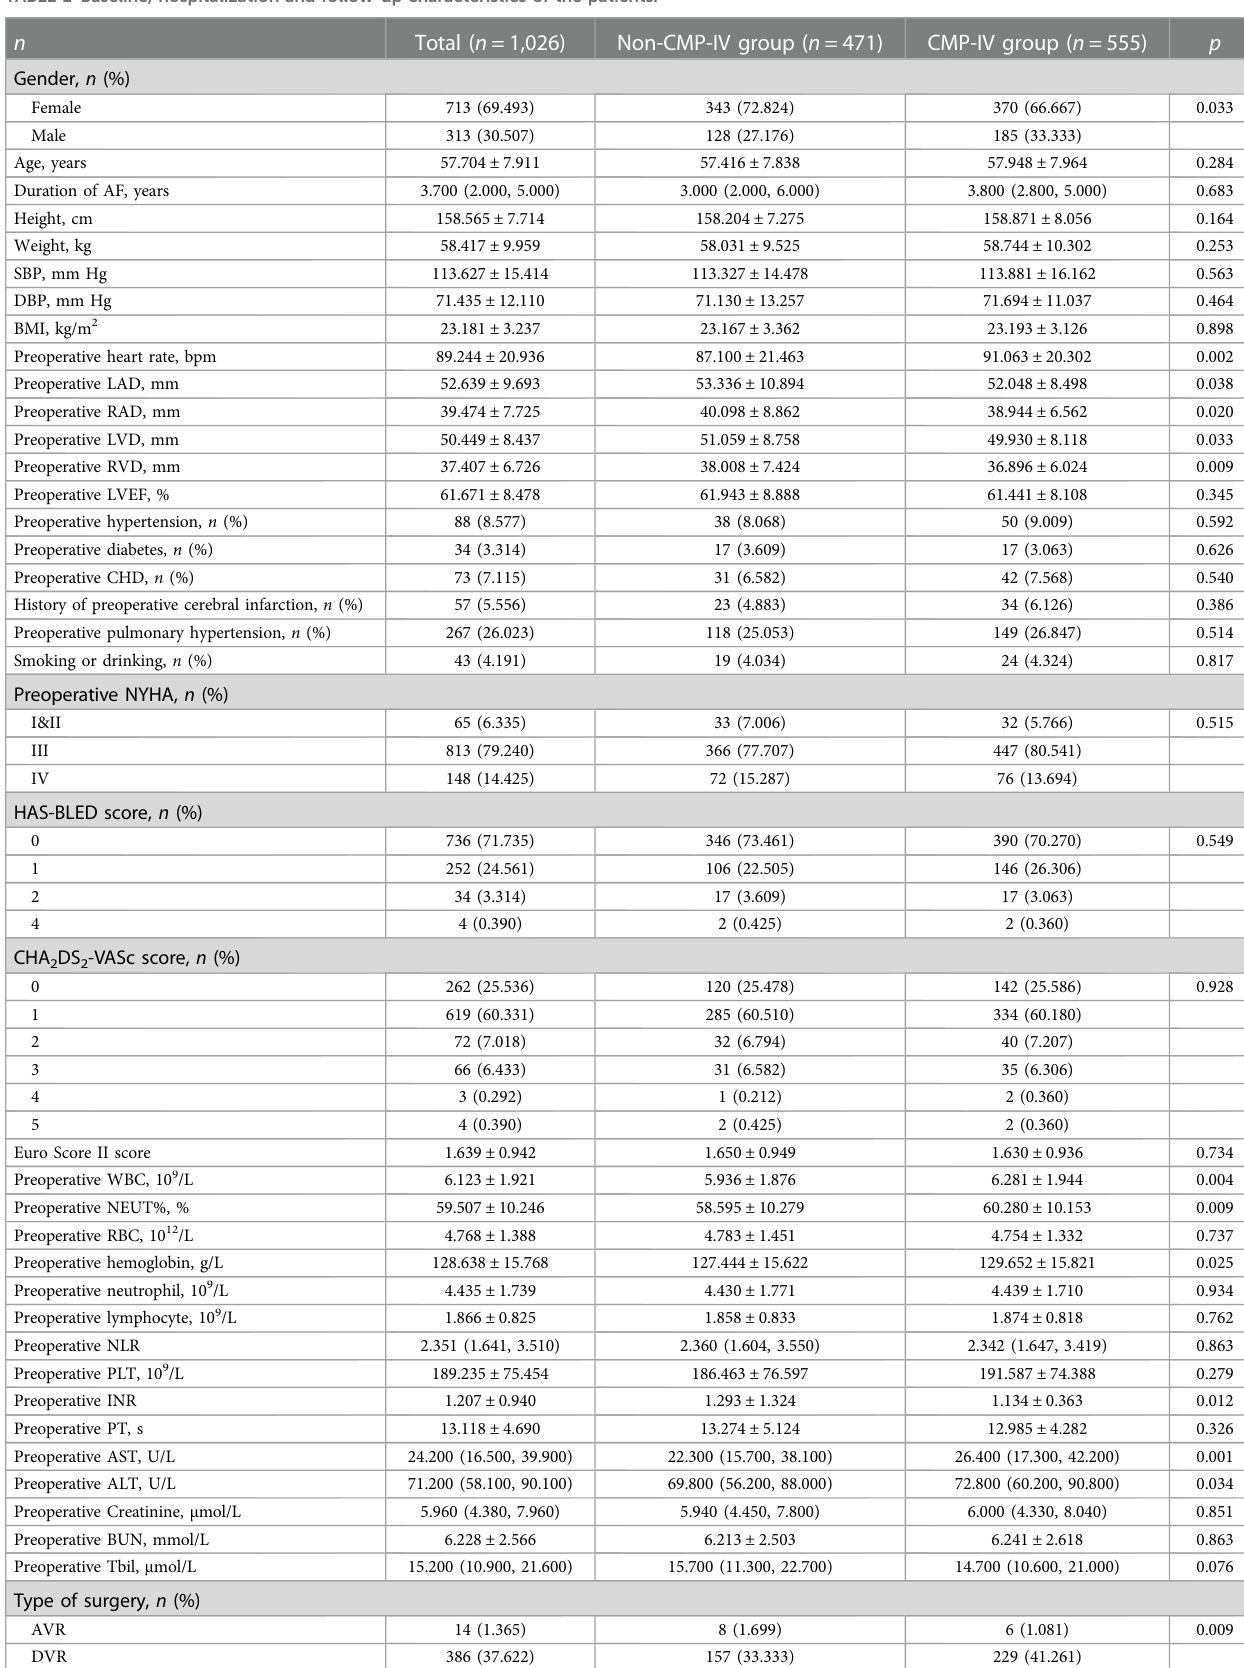
TABLE 1 Baseline, hospitalization and follow-up characteristics of the